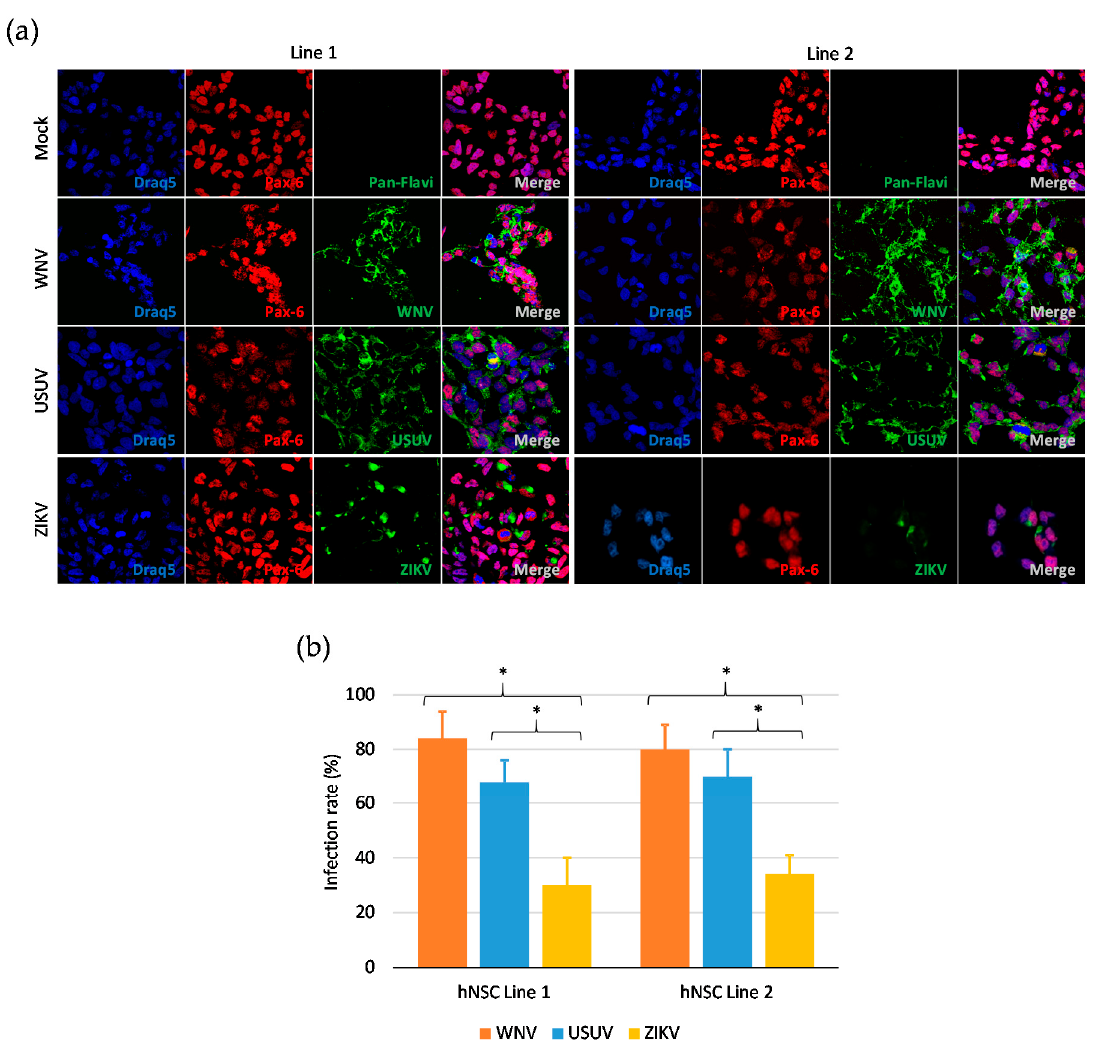
Figure 2. Flavivirus infection of human NSCs. ( a ) Confocal microscopy of NSCs of line 1 and line 2 at 48 hpi with West Nile virus (WNV) lineage 2, Usutu virus (USUV) Europe 1 and Zika virus (ZIKV) Asian lineage at multiplicity of infection (MOI) 1. NSCs were immunolabeled with a pan-flavivirus antibody targeting flavivirus E glycoprotein and with an antibody targeting the NSC marker Pax-6. Nuclei were stained with DRAQ5. 60× magnification zoomed two times. ( b ) Mean ± SD of the percentage of infected NSCs of line 1 and line 2 at 48 hpi with WNV, USUV and ZIKV at MOI 1. The percentage of infected cells was estimated by counting the number of immunolabeled cells to the total number of cells in 5 fields of view containing at least 100 cells, in triplicate experiments. * p < 0.05, Student’s t -test.